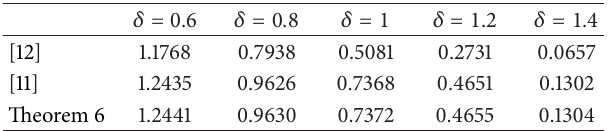
Table 2: Comparison of the allowable values of time delay ℎ for different decay